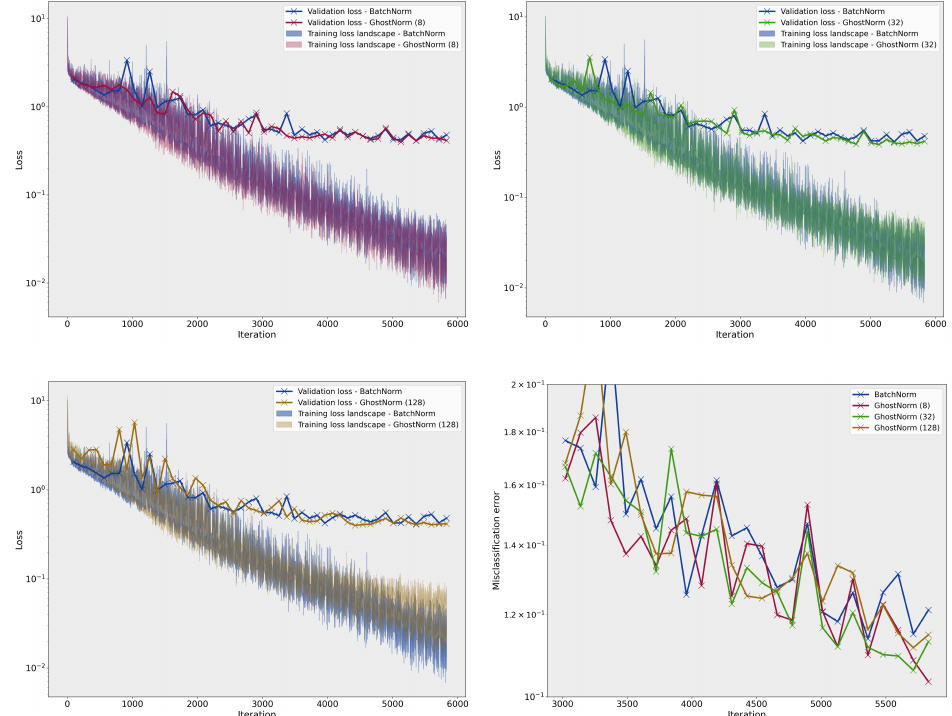
Figure A4. Comparison of the loss landscape on CIFAR–10 between BatchNorm and GhostNorm with different G M values. The last figure (bottom right) depicts the misclassification error on the testing set during